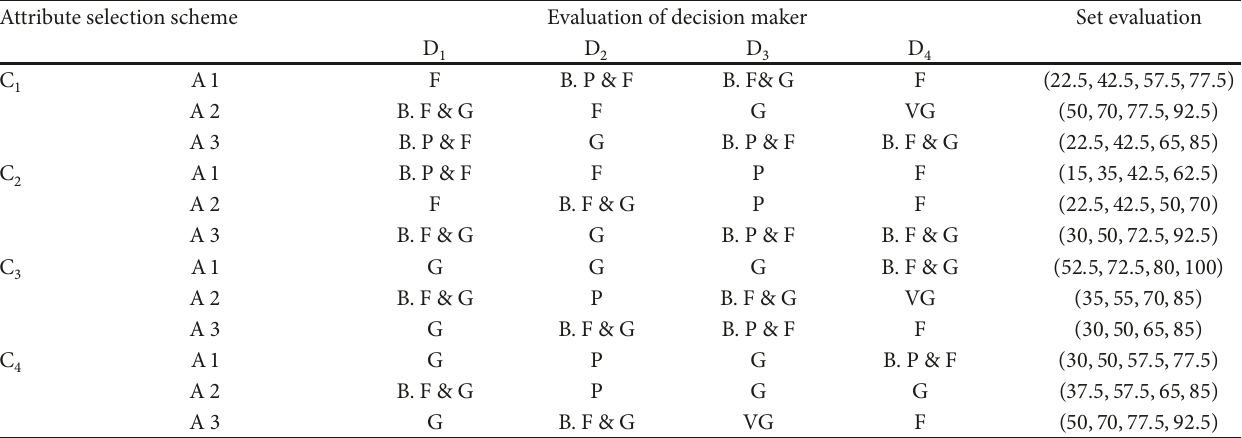
Table 6: Evaluation of decision makers under subjective evaluation attributes and set evaluation.